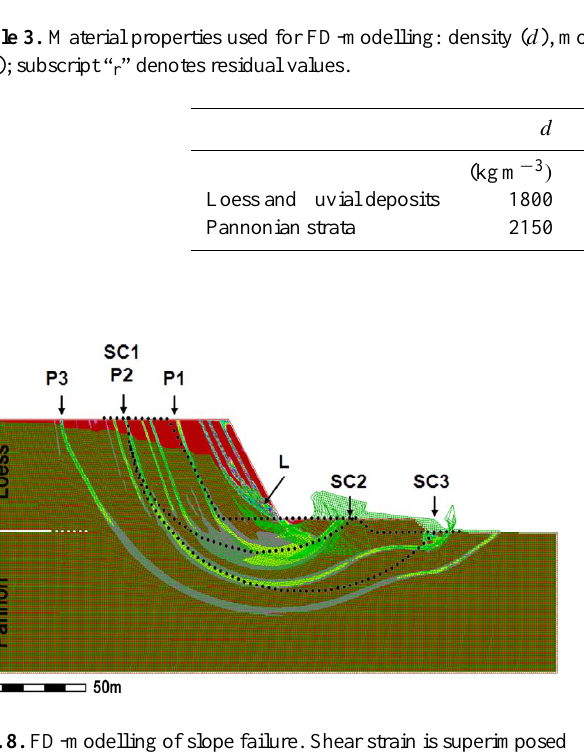
Figure 8. FD-modelling of the slope failure. Shear strain is superimposed on deformed grid. Sliding surfaces near the sliding plane face are denoted by L, successively developing sliding surfaces penetrating into the deeper Pannonian strata are denoted by P1, P2, and P3. The best fit of the primary and secondary slider blocks (Fig. 7) to the numerical model can be achieved under the assumption that failures of the loess wall occurred already in the past, the collapsed material has been removed by river erosion during floods, and P1 formed the loess face before the slope instability in 2008. The geometry of the slider block models shifted retrogressively is shown by dotted lines, SC1, SC2, and SC3 mark the scarps (see also Fig. 4).